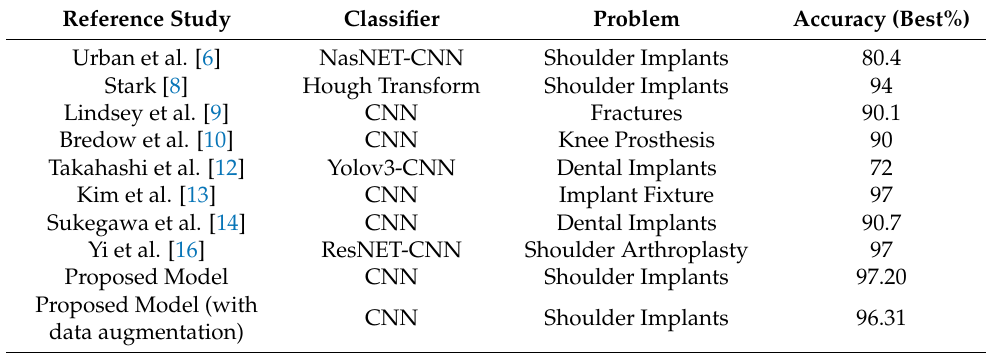
Table 4. Comparison of